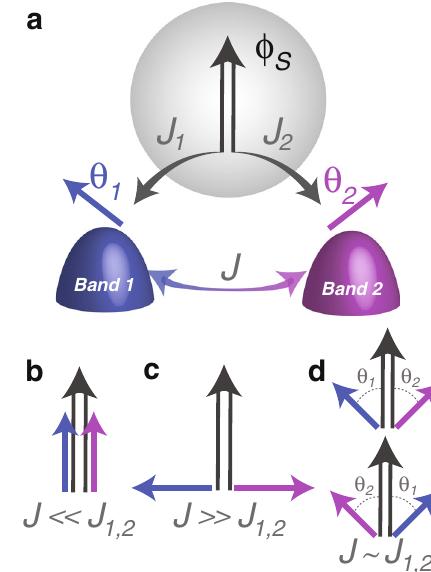
Fig. 3 Proximity effect in a two-band system. a The two bands in SnTe are coupled to the order parameter with phase ϕ S in aluminum via an external pairing fi eld for J 1 , J 2 . The interband coupling J is facilitated by the scattering of carriers between bands. θ 1 and θ 2 are the phases of individual order parameters in the two bands. b – d The competition between the coupling strengths J and J 1,2 results in different relative phases between two bands. b When J ≪ J 1,2 , the phases tend to align with each other. c When J ≫ J 1,2 , the phases of two bands are out of phase by π . d In the intermediate regime J ~ J 1,2 , the phases are canted (shown for the case degenerate states in the BTRS case are